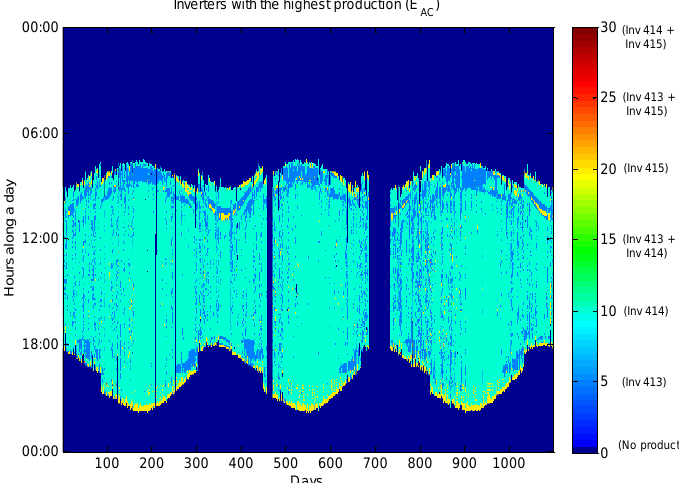
Inverters with the highest production (E AC )